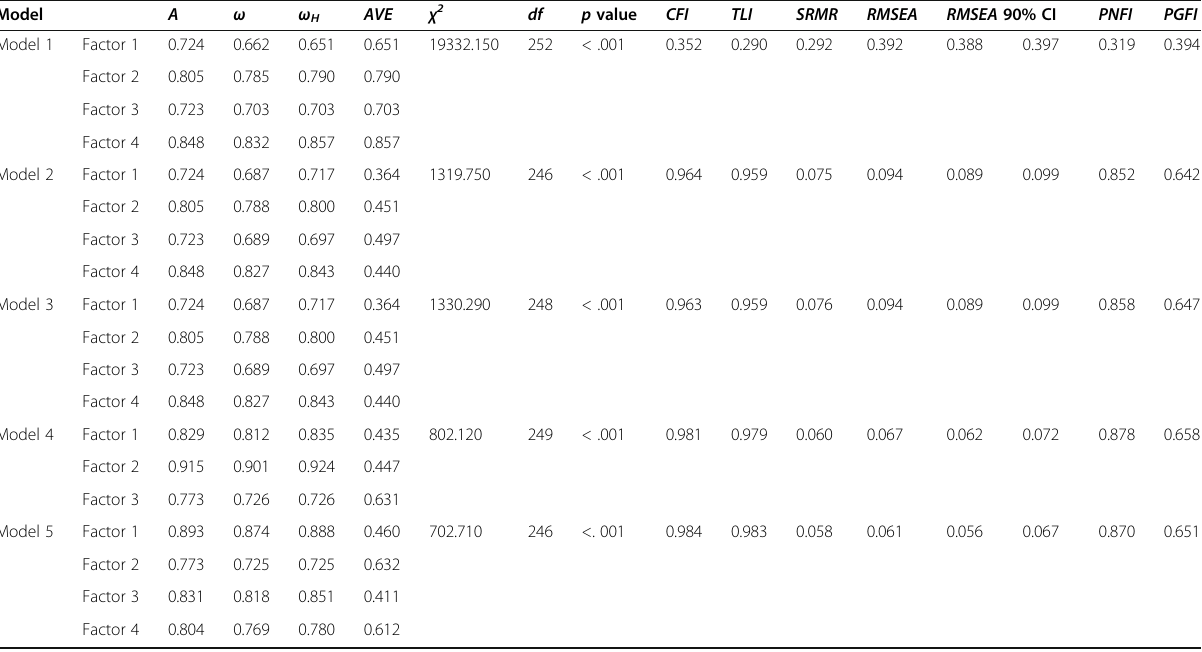
Table 4 Goodness of fit and internal consistency indices of the five models